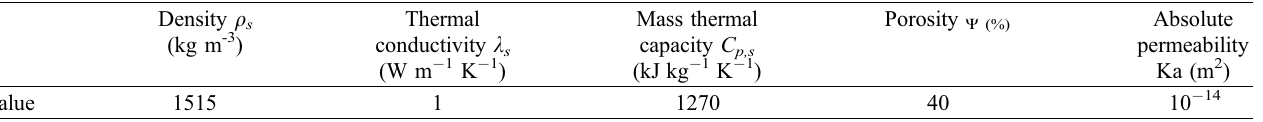
Table 2. Physical and thermal soil